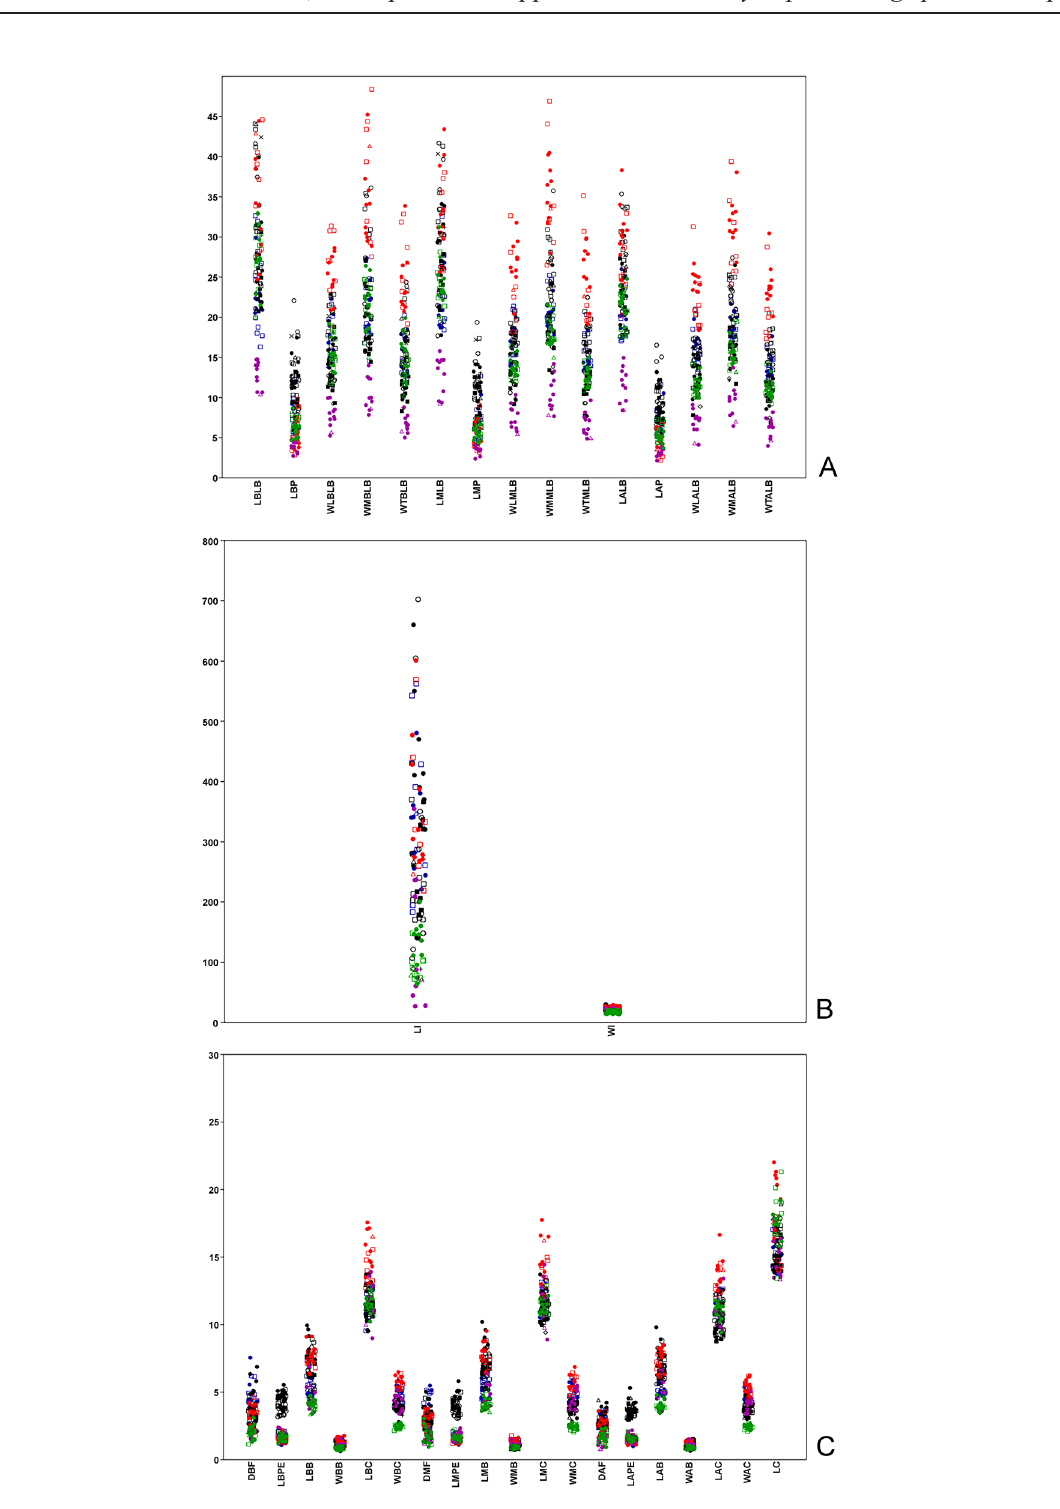
Fig. 4. Jitter Plots showing the variation in the Stachytarpheta longispicata complex of all characters selected for the morphometric analysis of the 115 sampled specimens (11 natural populations and eight type specimens of the Stachytarpheta longispicata complex). All measures are in millimetres. A . Leaf characters. B . Inflorescence characters C . Bracts and floral characters. For explanation of OTUs see Table 2; for character codes see Table